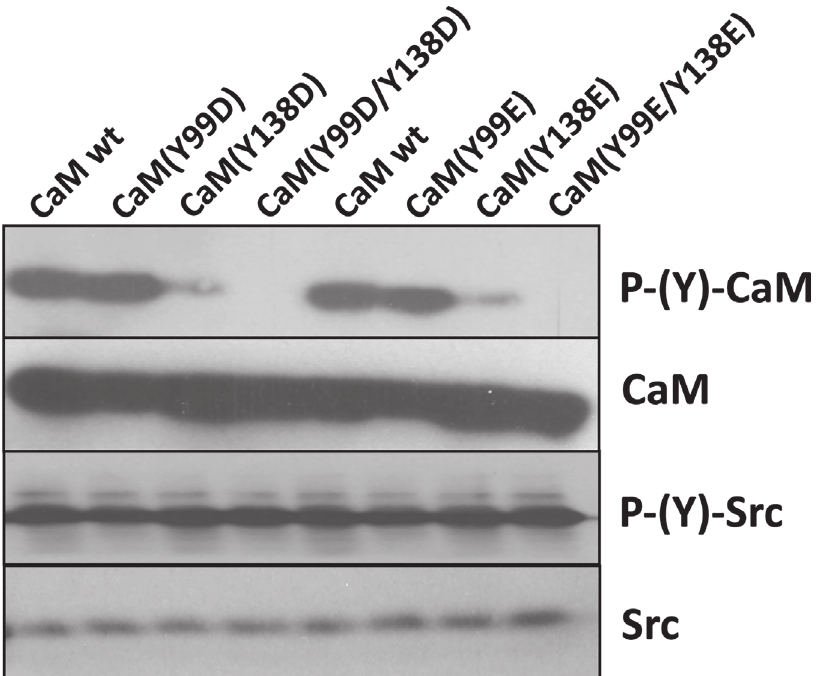
Fig 7. Phosphorylation of different CaM species by c-Src. The different CaM species (2 μ g) were assayed for phosphorylation by recombinant c-Src as described in Materials and Methods. The samples were probed with an anti-phospho-tyrosine antibody to detect the tyrosine-phosphorylated CaM species ( P- (Y)-CaM ) and auto-phosphorylated c-Src ( P-(Y)-Src ). The membranes were striped and reprobed with anti- CaM and anti-Src antibodies as loading